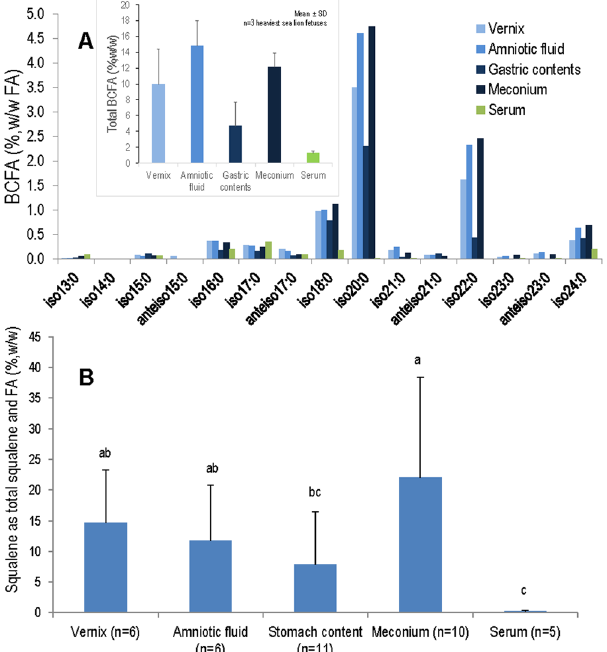
Figure 3. California sea lion fetal BCFA/squalene in vernix, amniotic fluid, gastric content, meconium, and serum (n = 6). ( A ) iso -BCFA C 18 - 24 dominate the distribution, similar to human BCFA, and unlike milkfat distributions C 14 - 18 (Supplementary Fig. 2). Serum BCFA distribution is dissimilar, C 16 - 18,24 , showing BCFA are only selectively transported to the circulation. Technical CV averages 3%. Inset: Summed BCFA in each substance for the three heaviest fetuses average about 10% except for serum. ( B ) Squalene is high in all substances except serum. Different letters signify a significant